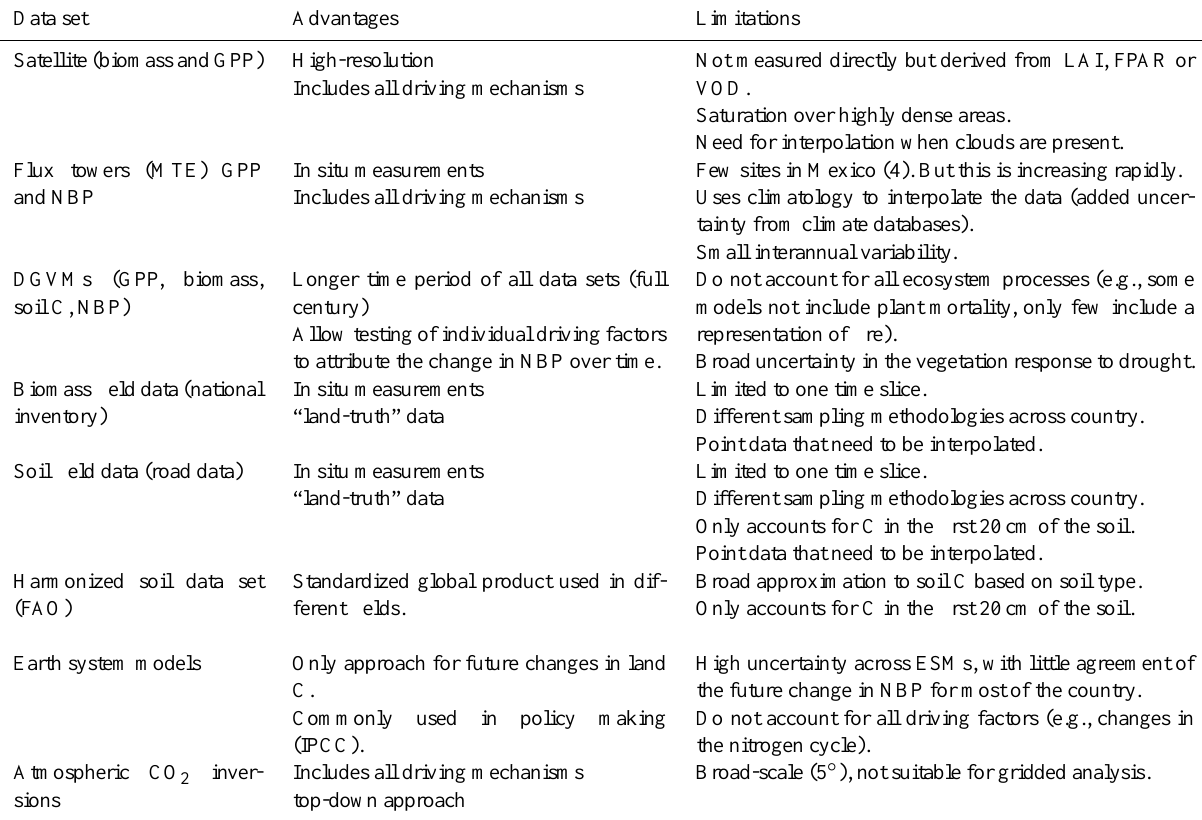
Table 2. Advantages and limitations of the different data sets